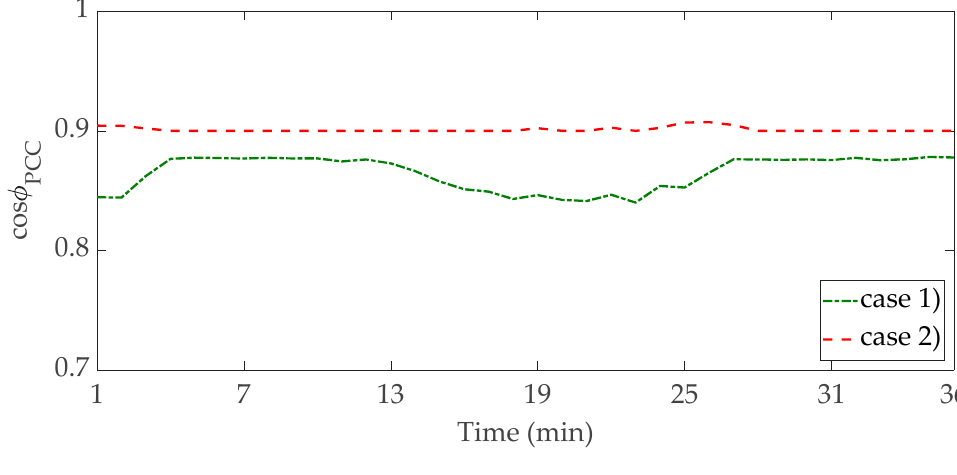
Figure 14. Power factor at the PCC. Table 4. Charging time of the PEVs for different arrival time